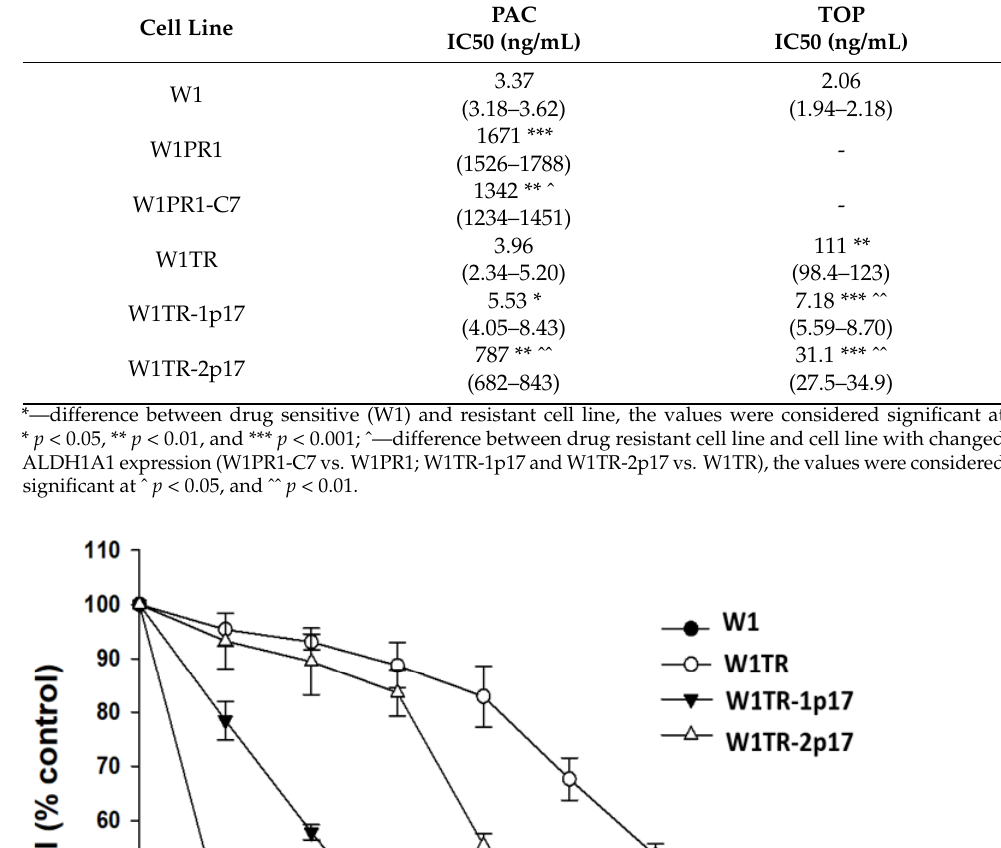
Table 1. Summary of cell line resistance to PAC (paclitaxel) and TOP (topotecan) in two dimensional (2D) cell culture conditions.